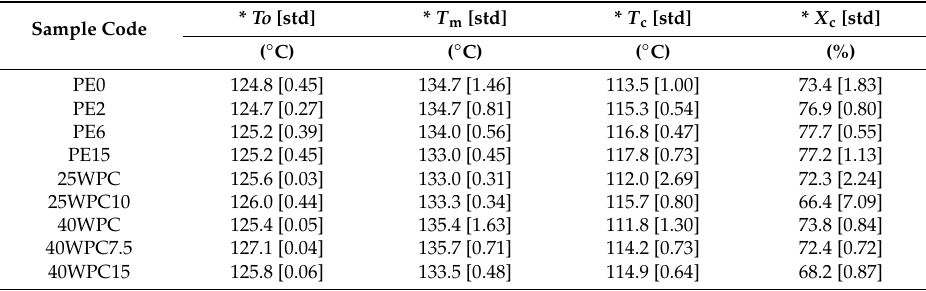
Table 7. DSC results of the di ff erent